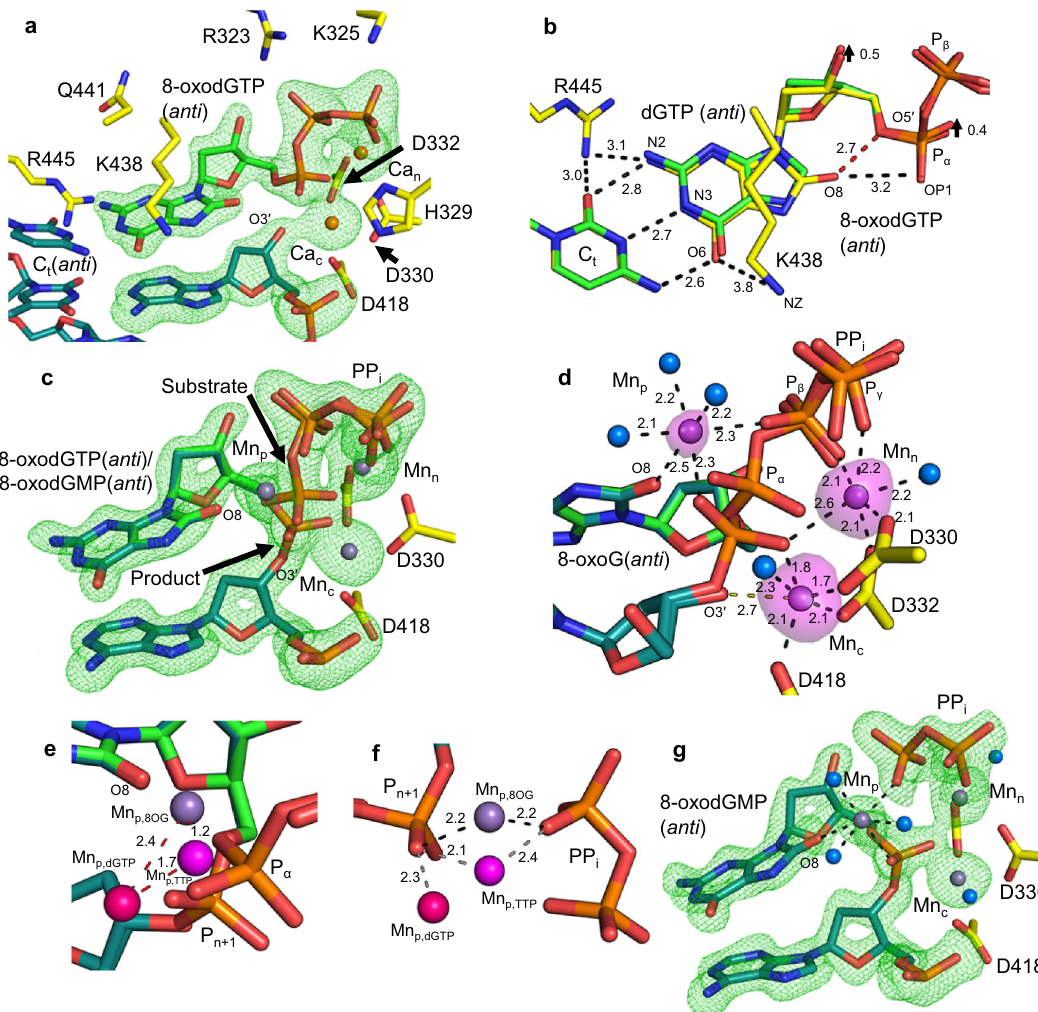
Fig. 4 8-oxodGTP insertion opposite C t . a Active site of the Ca 2 + -bound 8-oxodGTP( anti ):C t ( anti ) ground state (GS) ternary complex (PDB id 7KTA). Active site residues that interact with the incoming nucleotide or metals are shown. Ca 2 + atoms are displayed as orange spheres. Protein side chains are shown in yellow stick, DNA is in cyan, and the incoming nucleotide is in green. Simulated annealing (F o – F c ) omit density (green mesh) shown is contoured at 3.0 σ , carve radius 2.0 Å. b Top down close-up view of 8-oxodGTP( anti ) interactions in the active site (PDB id 7KTA). 8-oxodG and template bases (yellow) are shown overlaid with the Ca 2 + :dGTP( anti ):C t ( anti ) ground state complex (green). Arrows indicate differences in the positions of dGTP and 8-oxodGTP. Hydrogen bonding for 8-oxodGTP is shown with black dashes and distances (Å) are labeled. Clashes are shown with red dashes. c Active site of the Mn 2 + -reaction state (RS) ternary complex of pol μ inserting 8-oxodGTP( anti ) opposite C t (PDB id 7KTB). Ca 2 + :8-oxodGTP:C t ternary complex crystals were soaked in a Mn 2 + -containing cryo solution for 40 min. Arrows indicate bond broken (substrate) and formed (product). Mn 2 + atoms are purple spheres. d Active site metal coordination in the RS complex (PDB id 7KTB). Coordination is shown with dashes and distances (Å) are labeled. Water molecules are shown as blue spheres. Anomalous density (magenta surface) is contoured at 5 σ . e Comparison of the locations of Mn p,8-oxodGTP (purple) (PDB id 7KTB), Mn p,dGTP (pink) (PDB id 7KSU), and Mn p,TTP (magenta) (PDB id 5TYX) displayed overlaid on the Mn 2 + :8-oxodGTP( anti ):C t ( anti ) reaction state ternary complex (PDB id 7KTB). Red dashes indicate distances between metal ions. f Comparison of Mn p,8-oxodGTP (purple) (PDB id 7KTB), Mn p,dGTP (magenta) (PDB id 7KSU), and Mn p,TTP (pink) (PDB id 5TYX) coordination by the incorporated phosphate (P n + 1 ) and phosphate oxygen of PP i in the 8- oxodGTP( anti ):C t ( anti ) reaction state ternary complex (PDB id 7KTB, 8-oxodGTP not shown for clarity). Coordination distances (Å) are shown with black dashes for Mn p,8OG and with grey dashes for Mn p,dGTP and M np,TTP . g Active site of the product state of the 8-oxodGTP( anti ):C t ( anti ) insertion (PDB id 7KTC). Ground state ternary complex crystals were soaked in a Mn 2 + -containing cryo solution for 120 min.